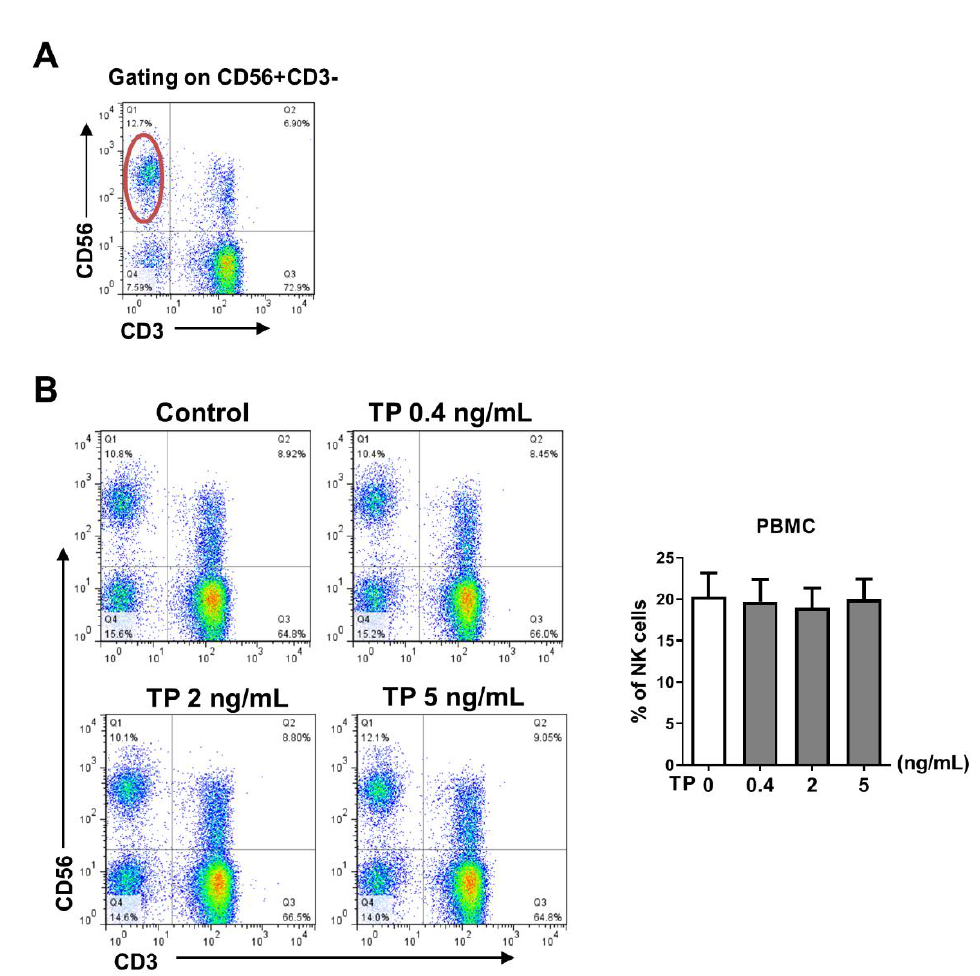
Figure 1. Effect of TP on the proportion and the viability of peripheral blood NK cells in normal human PBMCs. Human PBMCs isolated from health donors were incubated with different concentrations of TP (i.e., 0, 0.4, 2, and 5 ng/mL) for 24 h. ( A ) Representative FACS analysis shows the gating strategy of CD56+CD3 − cells (NK cells). ( B ) The percentage of CD56+CD3 − cells was detected by flow cytometry in PBMCs. Data were analyzed by one-way analysis of variance with a multiple comparisons test ( n = 6).